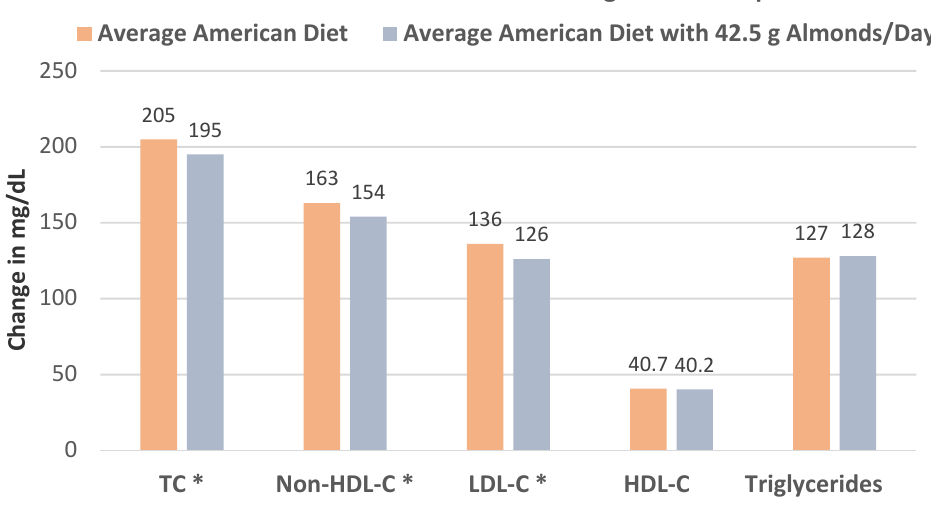
Figure 19. Effect of the average American diet and the average American diet with almonds on blood lipids in overweight and obese individuals from baseline to 4 weeks, with the inclusion of almonds lowering LDL-C by 4%, non-HDL-C by 5%, and LDL-C by 7% (* p <0.05) [77]. Jung et al. [46], in a crossover RCT, randomly assigned 84 healthy overweight and obese Korean adults (87% women, mean age 52 years) to a 65% energy carbohydrate and 21% energy from fat Korean diet plus daily snacking on 56 g/day of roasted almonds or 79 g/day isocaloric home-made cookies for 4 weeks each. Snacking on almonds signifi- cantly decreased TC, LDL-C, and non-HDL-C by 5.5%, 4.6%, and 6.4% respectively, relative to the cookie control ( p ≤ 0.05). Almonds also significantly reduced IL-10 compared to the cookie control by 22% ( p < 0.04), and elevated levels have been associated with poor CVD prognosis [78]. There was a tendency to reduce inflammatory biomarkers intercellular adhesion molecule -1(ICAM-1), IL-1 β , and IL-6 with almonds, compared to the cookies ( p ≤ 0.187). No notable changes were observed in plasma ox-LDL, malondialdehyde, carbonyls, hs-CRP, tumor necrosis factor (TNF)-alpha, vascular cell adhesion molecule- (VCAM-1), or blood glucose status. Almonds increased plasma α -tocopherol by 8.5% ( p ≤ 0.05) and decreased ỷ -tocopherol by 18% ( p = 0.01) from the baseline. The almond diet improved the unsaturated - saturated fatty acid ratio and fiber intake while decreasing % energy intake from carbohydrate. The investigators concluded that snacking on almonds by overweight or obese Koreans in the typical Korean diet improves nutrition quality and reduces cardiovascular disease risk relative to a cookie snack. Dikariyanto et al. [45], in a parallel RCT, randomized 107 healthy subjects (56 years, 70% women, mean BMI 27) into an average United Kingdom diet, including 20% of the daily energy intake from a snack of roasted almonds (63 g, ¼ cup) or an isocaloric control snack of mini-muffins for 6 weeks. Compared to the control sweet and savory muffin snack, almond snacking significantly reduced non-HDL-C and LDL-C, and increased